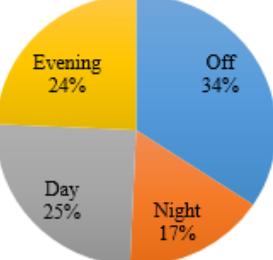
Figure 3. Percentage Distribution of Shifts.